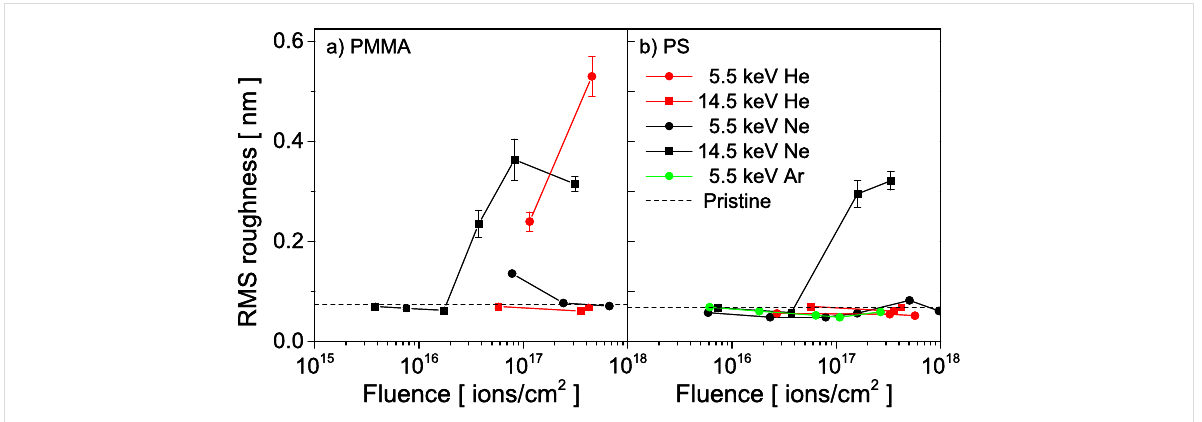
Figure 2: RMS roughness changing with primary He + and Ne + fluence when bombarding (a) PMMA and (b)